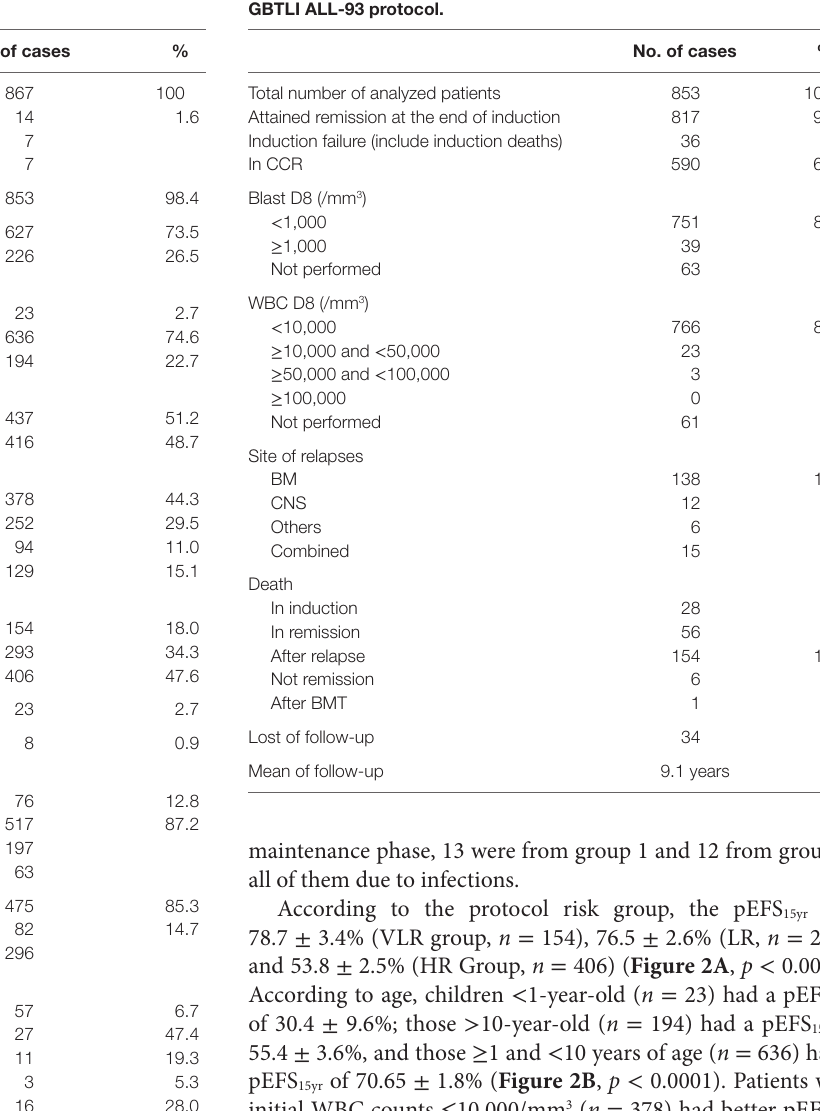
TaBle 4 | clinical outcomes of 853 all patients treated according to gBTli all-93 protocol.